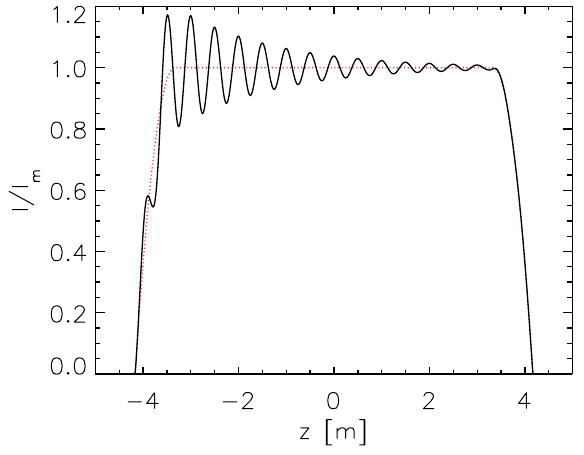
FIG. 3. (Color) Momentum spread increase in a coasting beam with the velocity distribution Eq. (29) as a function of initial (cid:1) U; V (cid:5) values. The black area corresponds to a stable beam.